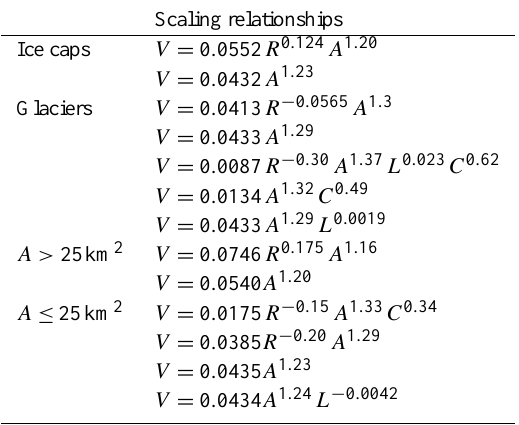
Table 4. Volume scaling relationship obtained from minimizing the absolute volume deviation with the scaling constant constrained by total volume. These relationships are expressed in Kelvin, km, km 2 and km 3 units. More decimal places are retained than is significant to facilitate conversion to other units. The scaling laws within each group are ordered by performance in the RGI and secondly in the WGI/GLIMS cross validations.